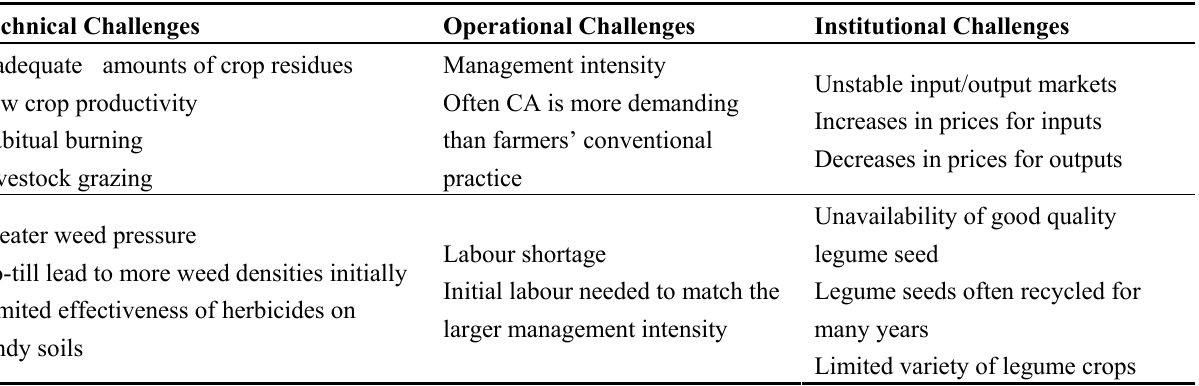
Table 7. Some of the major challenges of implementing conservation agriculture mentioned during focus group discussions in Zidyana, Malawi and Zimuto,